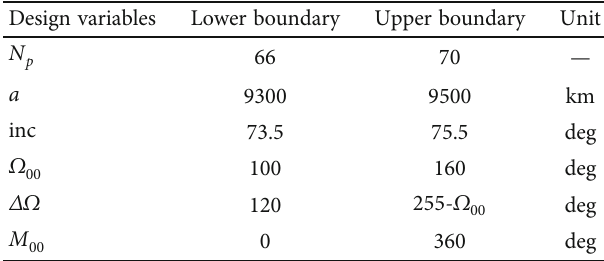
Figure 7: 70-satellite Walker constellation, which is the result for the optimization model with continuous object. (a) View from azimuth = 160 ° and elevation = 45 ° ; (b) view from azimuth = 110 ° and elevation = 90 ° . Table 5: Constraints on the design